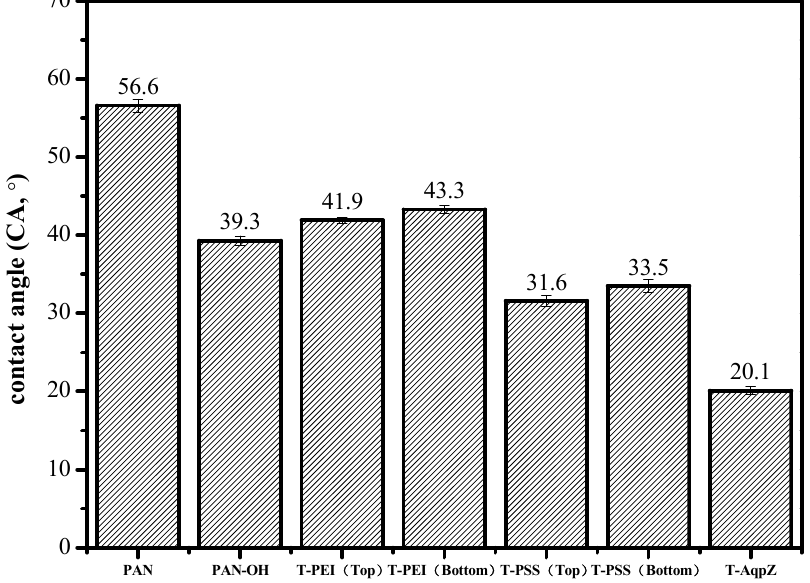
Figure 3. Contact angles of PAN, H-PAN, T-PEI (top surface), T-PEI (bottom surface), T-PSS (top surface), T-PSS (bottom surface), and T-AqpZ